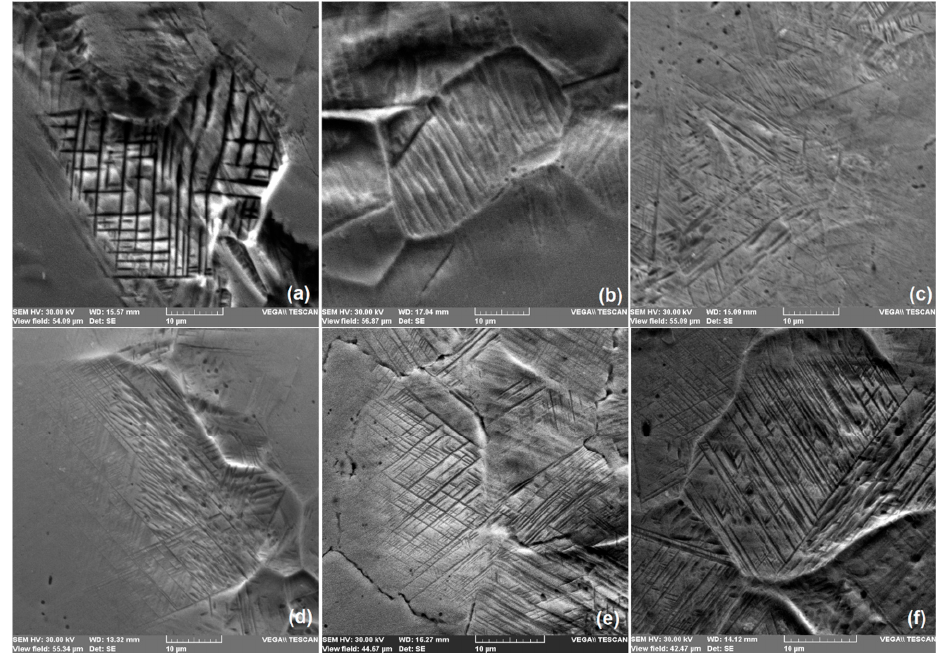
Figure 4. SEM micrographs in the solution-treated state: ( a ) 0_MA_700 ; ( b ) 0_MA_1100 ; ( c ) 20_MA_700 ; ( d ) 20_MA_1100 ; ( e ) 40_MA_700 ; ( f ) 40_MA_1100 .